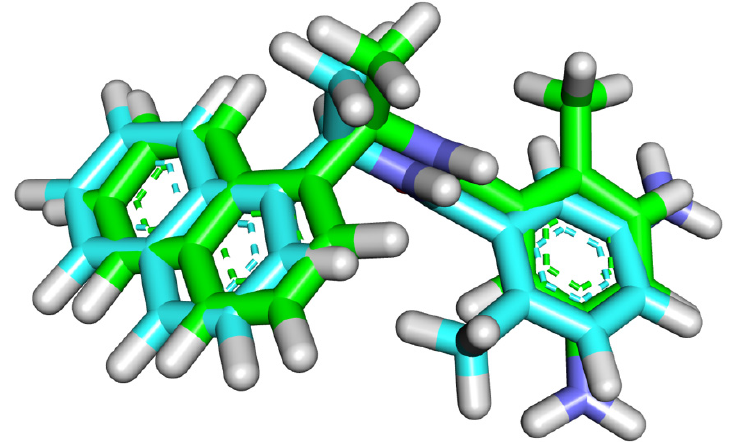
Figure 6. Superimposition of the co-crystallized molecule (Turquoise) and the docking pose (dark green) of the same molecule.